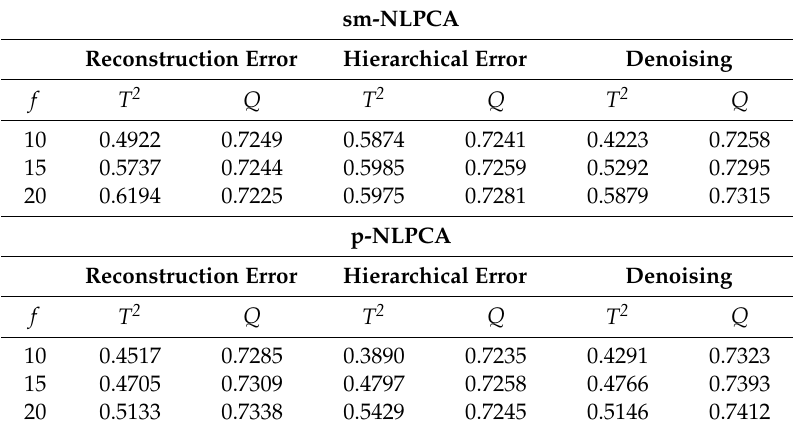
Table 11. Process monitoring results with di ff erent neural network training objective functions and adjusted upper control limits (FAR = 0.01 for normal test